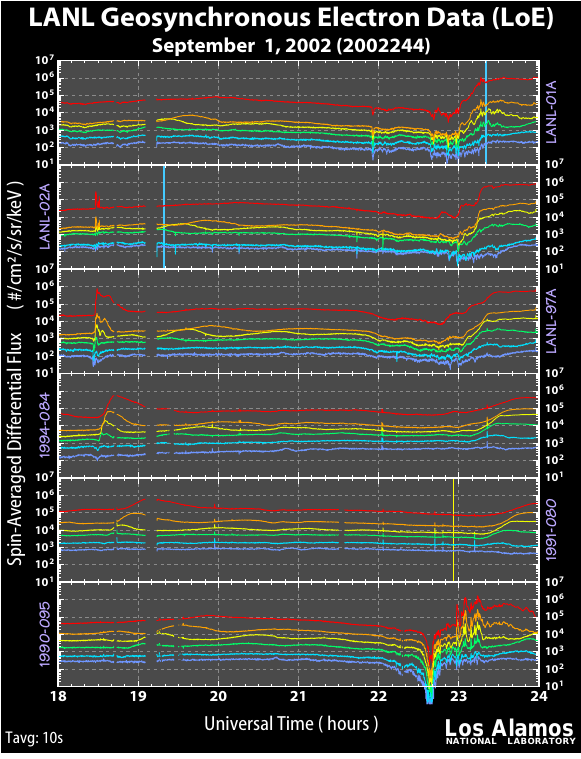
Fig. 15. LANL low energy electron data from the SOPA instrument are shown for 1 September 2002 (18:00 to 24:00 UT